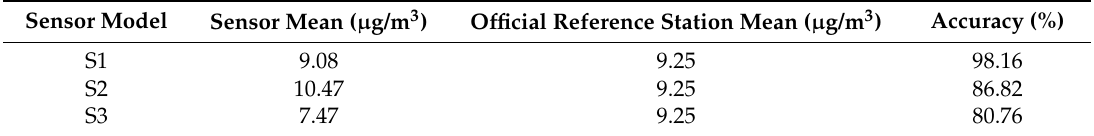
Table 3. Long-term averaged data accuracy from sensors.